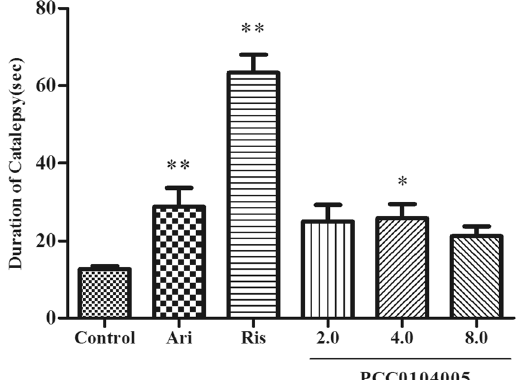
Figure 7. The effect of PCC0104005 on catalepsy duration in mice. Mice were administered an oral dose of vehicle alone (0.5% methylcellulose in water, 1 ml/kg) or PCC0104005 (2.0, 4.0, or 8.0 mg/kg), aripiprazole (2.0 mg/kg) or risperidone (Ris, 0.25 mg/kg)1 h before the test. The longest duration of catalepsy in each mouse was recorded. Results are presented as mean ± S.E.M. (n = 8). * P < 0.05, ** P < 0.01 drug delivery groups vs. the control group.